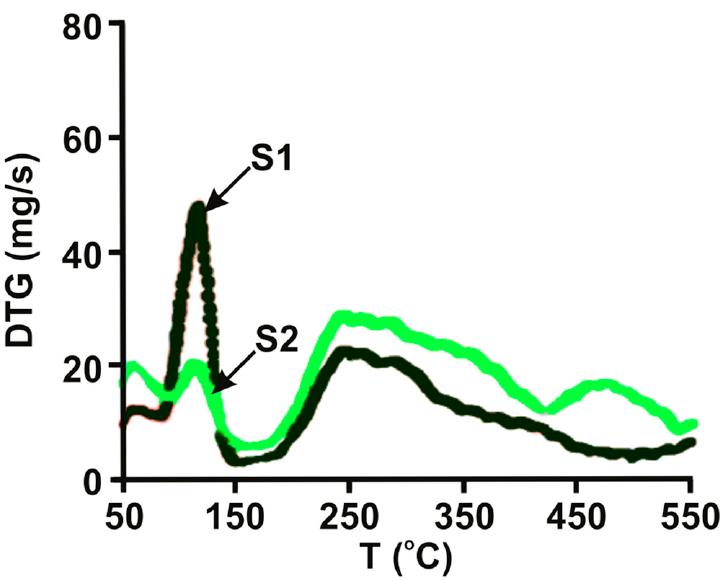
Figure 9. Thermogravimetric TGA analysis of Posidonia samples of various fractions: single sample before and after sieving (500 > L > 125 µm).